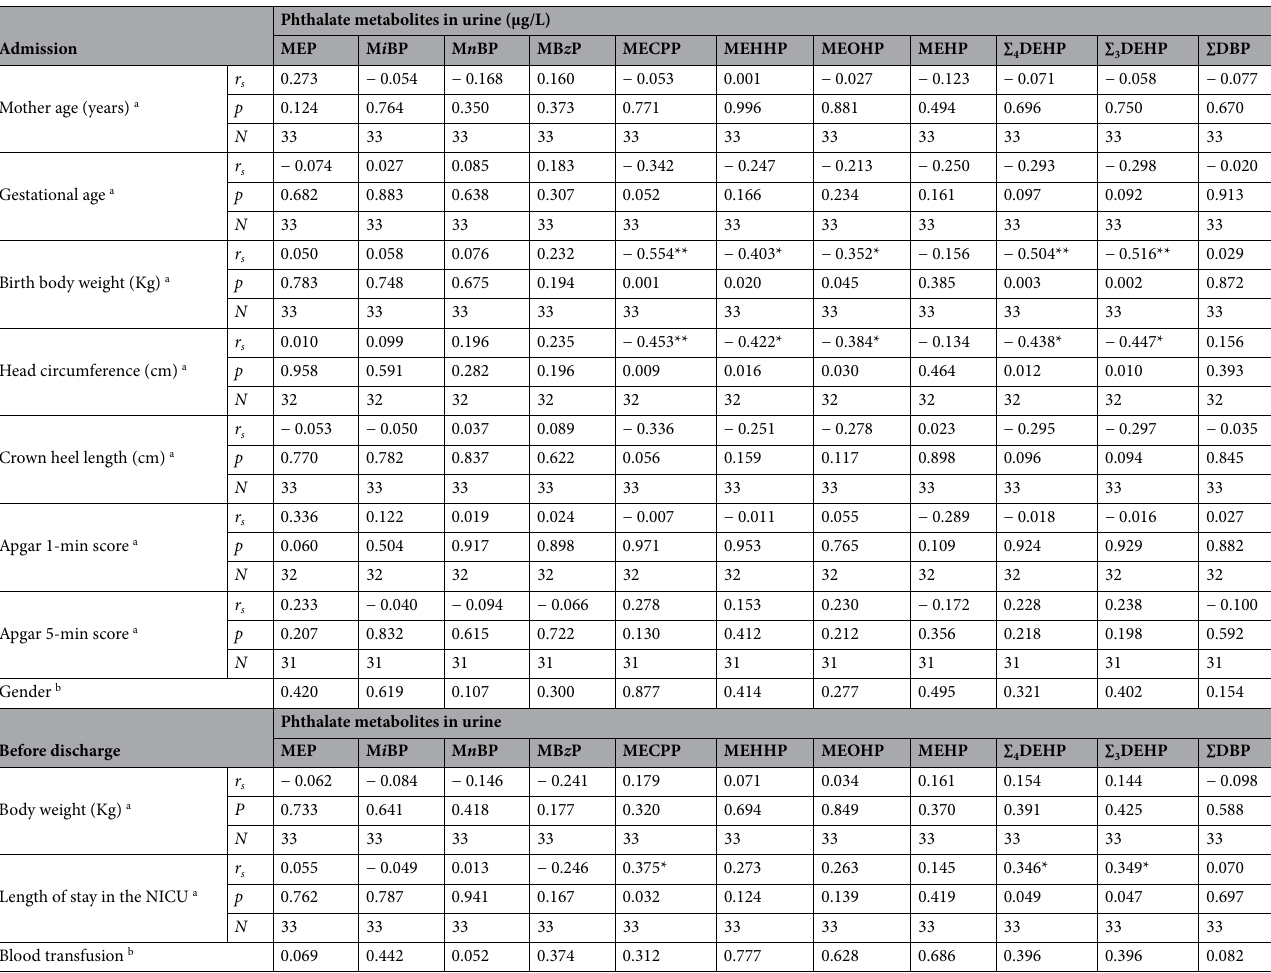
Table 4. Bivariate analyses between the levels of phthalate metabolites in urine collected from preterm neonates at NICU and some confounding variables. a Spearman rank correlation test [**Correlation is significant at the 0.01 level (2-tailed)/ *Correlation is significant at the 0.05 level (2-tailed)]. b Mann-Whitney test.